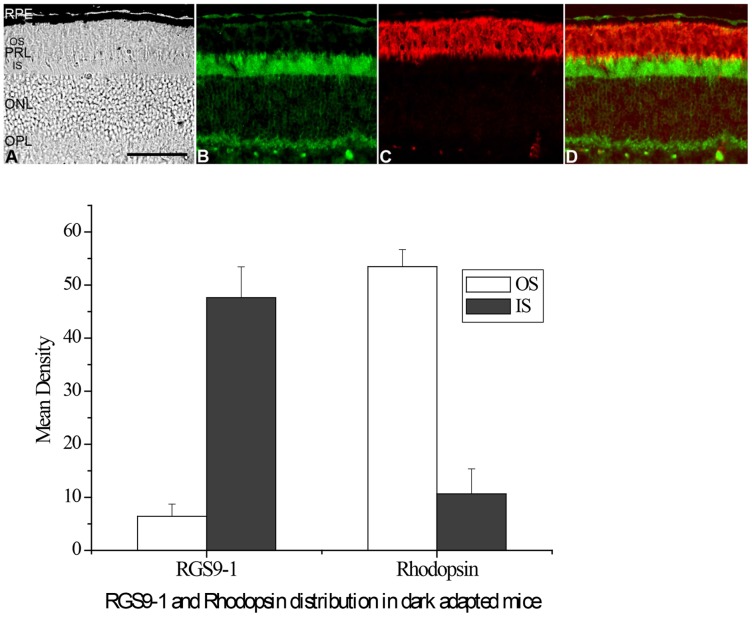
Double labeling studies using anti-RGS9 and anti-rhodopsin antibodies on dark adapted mouse retina isolated and processed in complete darkness.Upper panel: A: the DIC image of an 8-hours dark adapted mouse retinal section indicates structural integrity of rod outer segments. This retinal section was used for a double-immunostaining of RGS9 and rhodopsin (can be recognized by the shape of RPE in A, B and D). After prolonged dark adaptation, RGS9-1 (B) is located primarily in rod inner segments and rhodopsin (C), which, in normal wild type mice, is always located in rod outer segments and is not translocated by light, is located in the rod outer segments. D: Double-immunostaining (Merge) of RGS9-1 and rhodopsin in the same region. Lower panel: Analysis of the average levels of RGS9-1 and rhodopsin in the outer segment layer and inner segment layer; n = 8. Labels are the same as in Fig. 1.